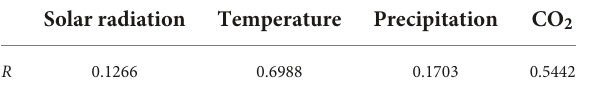
TABLE 1 The correlation coefficient between NPP and different climate factors.